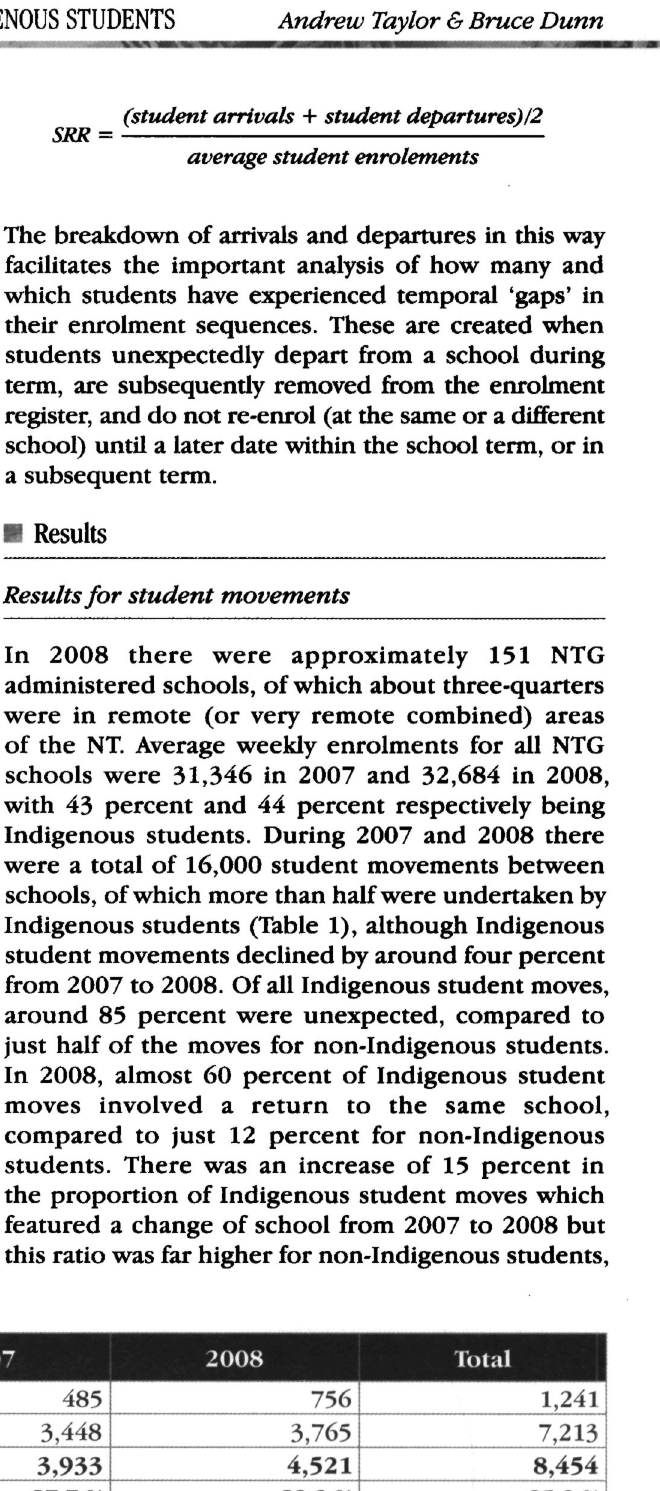
Table 1. Student movements by Indigenous status, 2007 and